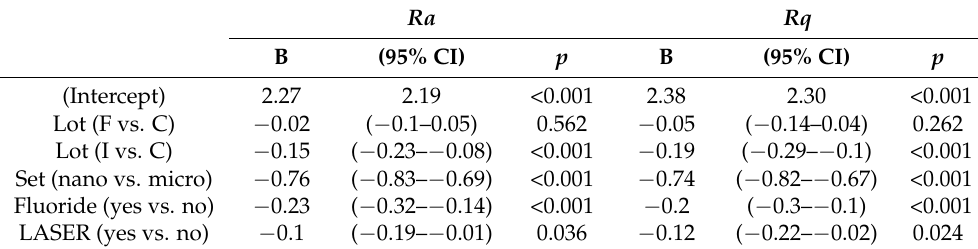
Table 2. Roughness multivariate model coefficients.